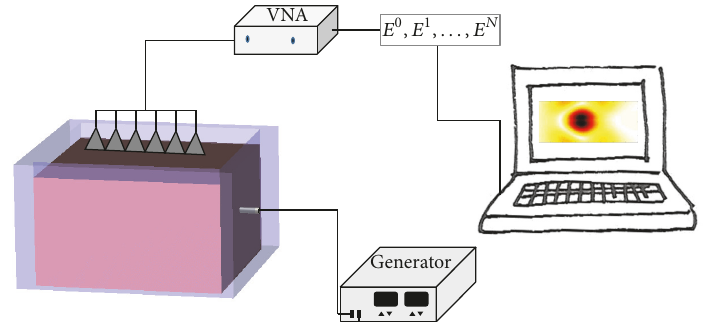
Figure 1: Conceptual scheme of the MWT monitored